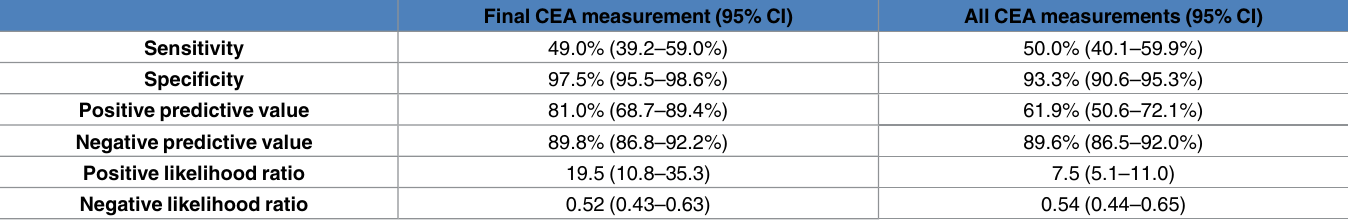
Table 1. Comparison of the diagnostic performancein detecting recurrence of a rise in blood CEA level above a threshold of 5 μ g/L in relation to i) all CEA measurements taken prior to diagnosis of recurrenceand ii) the final CEA measurement taken prior to diagnosis of recurrence.